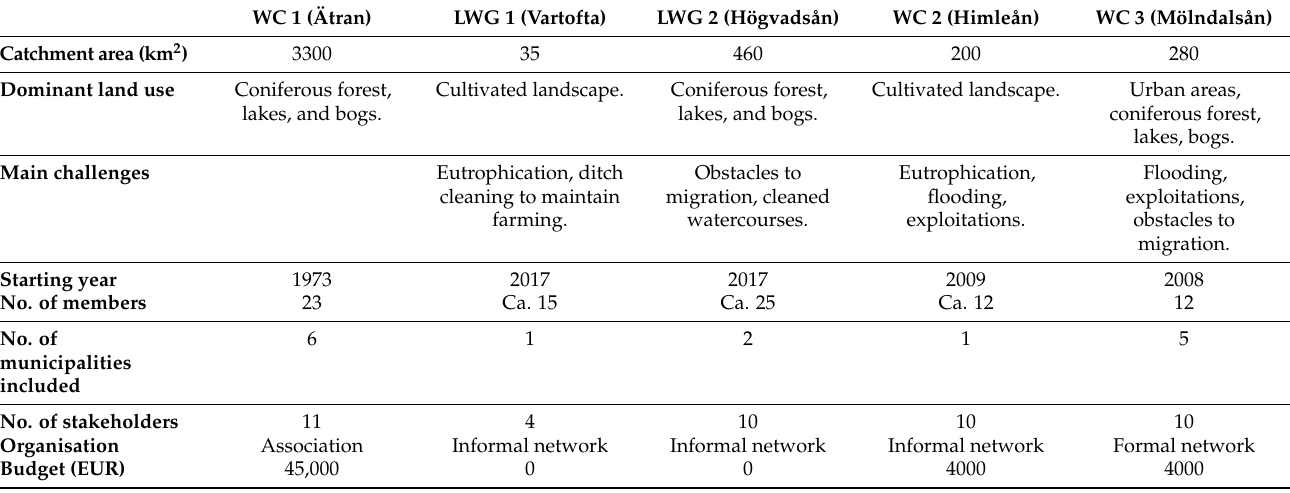
Table 2. Differences and similarities between conditions in the four pilot projects (Ätran WC was split into two local pilot projects). WC: water council. LWG: local water group.